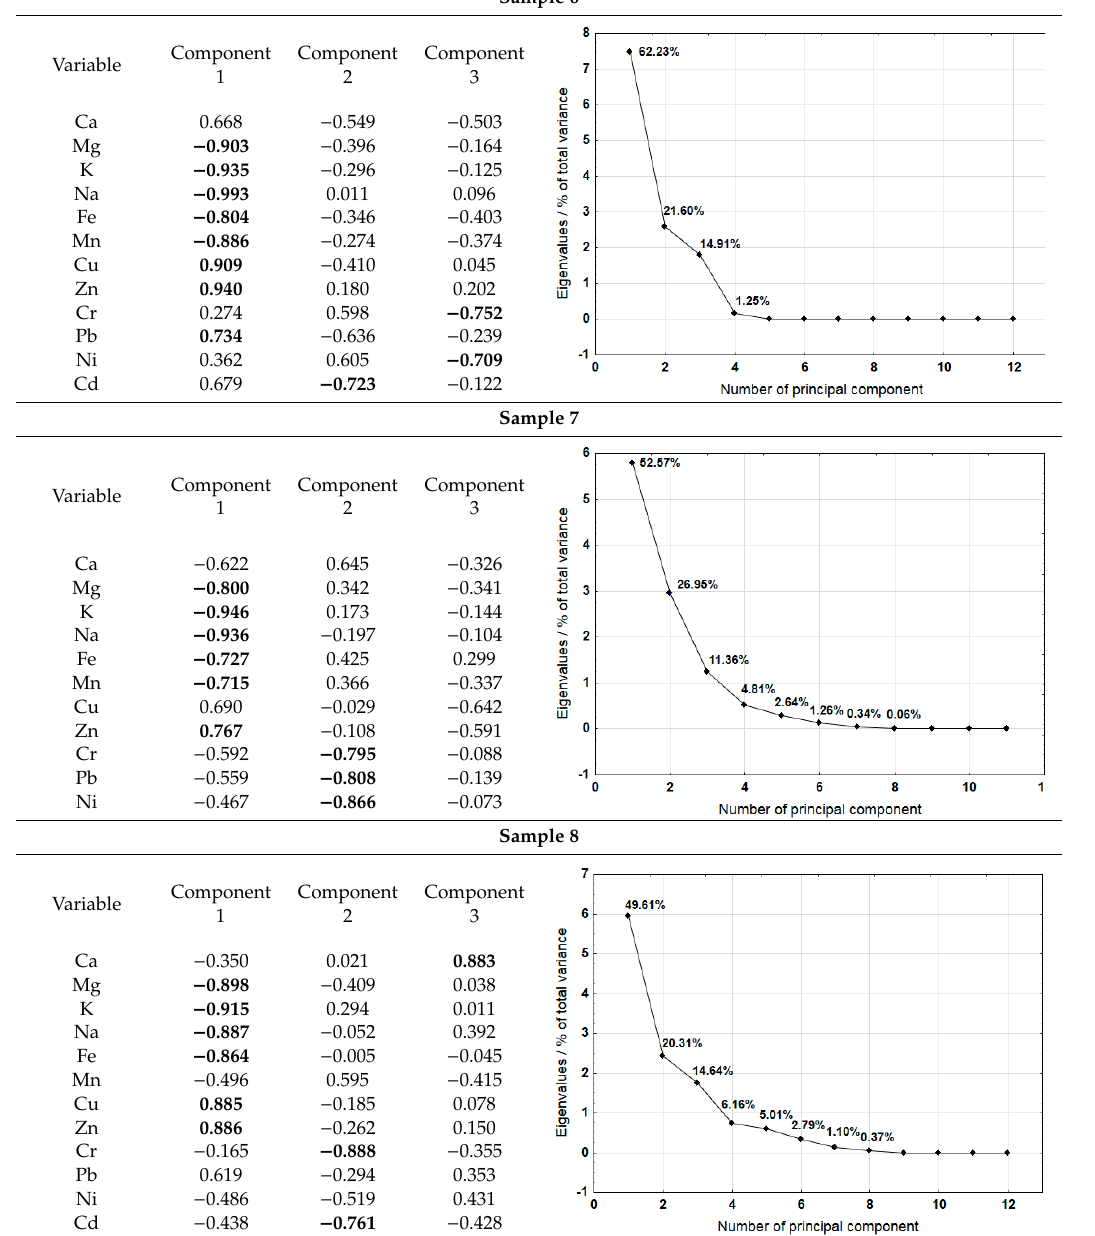
Table 8. The results of the Principal Component Analysis (PCA) for samples 6, 7, and 8. Sample 6